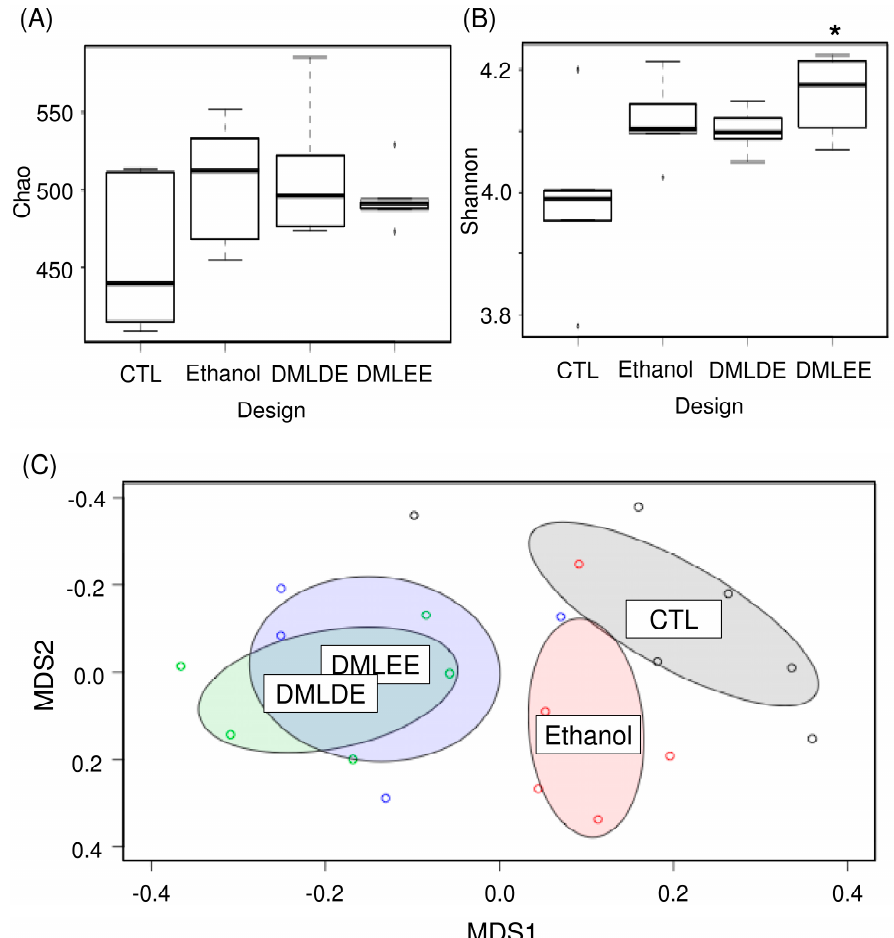
Figure 5. The comparative analysis of gut microbiota using ecological indices and non-metric multidimensional scaling (NMDS). ( A ) Species richness, ( B ) species evenness, and ( C ) NMDS. * indicates significant difference between CTL and DMLEE.